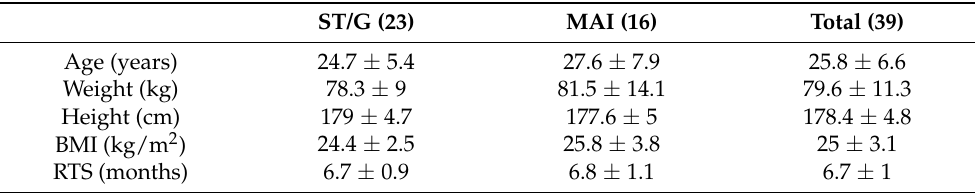
Table 1. Descriptive